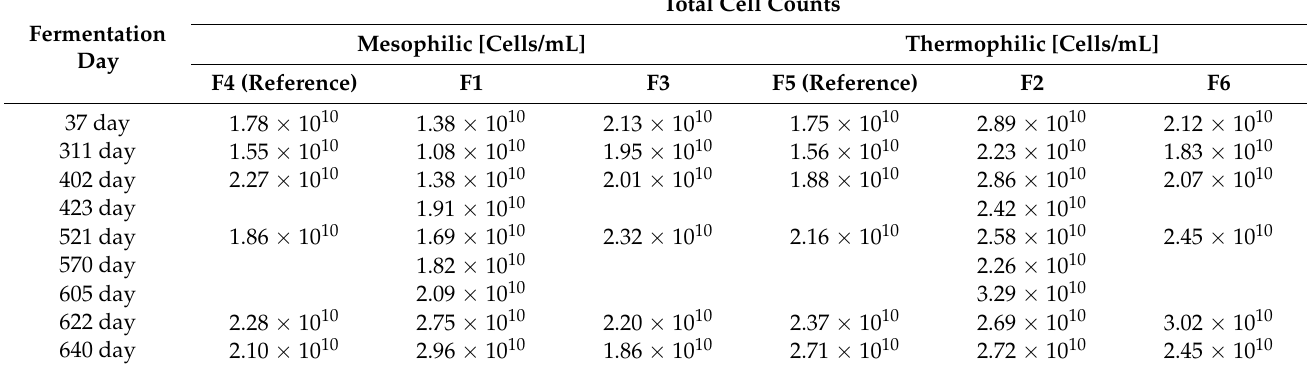
Table 5. Semi-automated total cell counts, with a quantitative microscopy, during long-term anaerobic digestion of wheat straw, with ‘synthetic manure’ in the six fully automated and continuously stirred fermenters F1–F6. Total cell counts were obtained by staining with CyberGreen and included the